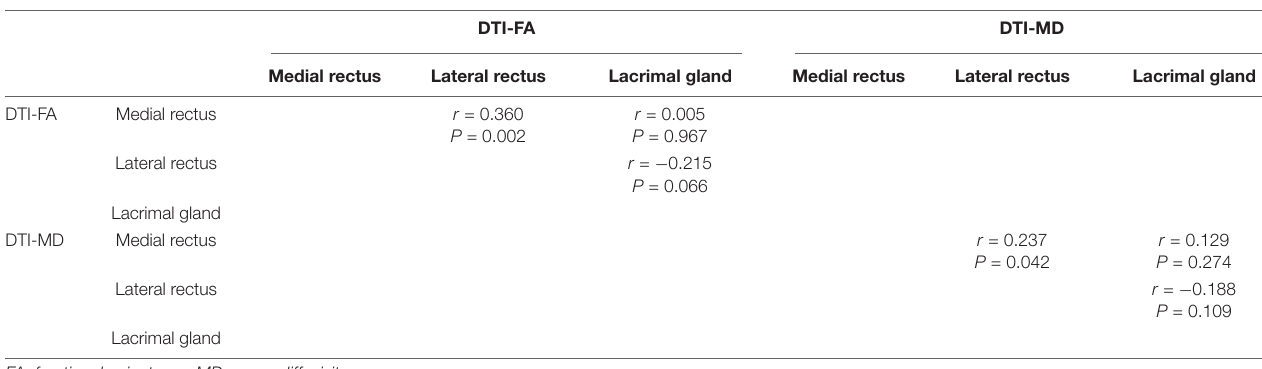
TABLE 5 | Correlations matrix of orbital soft tissue DTI parameters.